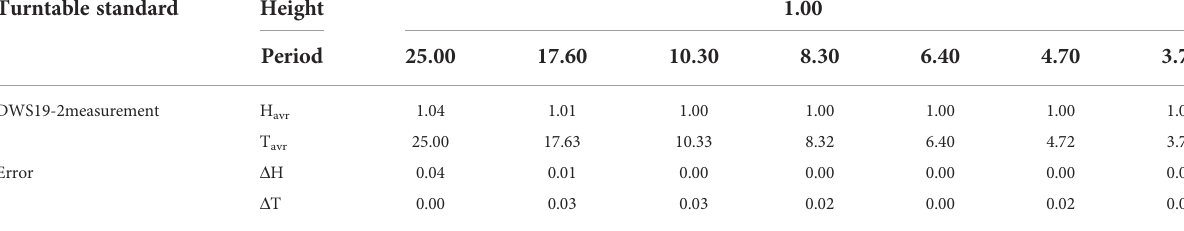
TABLE 2 Measurement at a height of 1 m (height unit: m; period unit: s).